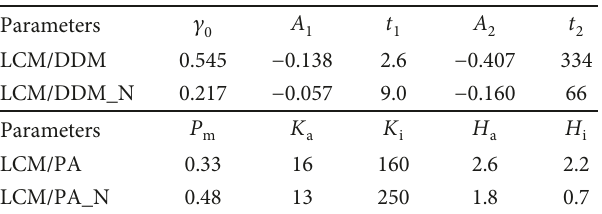
Table 2: Kinetic parameters of the reaction progress in various systems. Values determined from the best fi t of the double-decay function (7) for mixtures with DDM and the Hill equation (8) for systems with